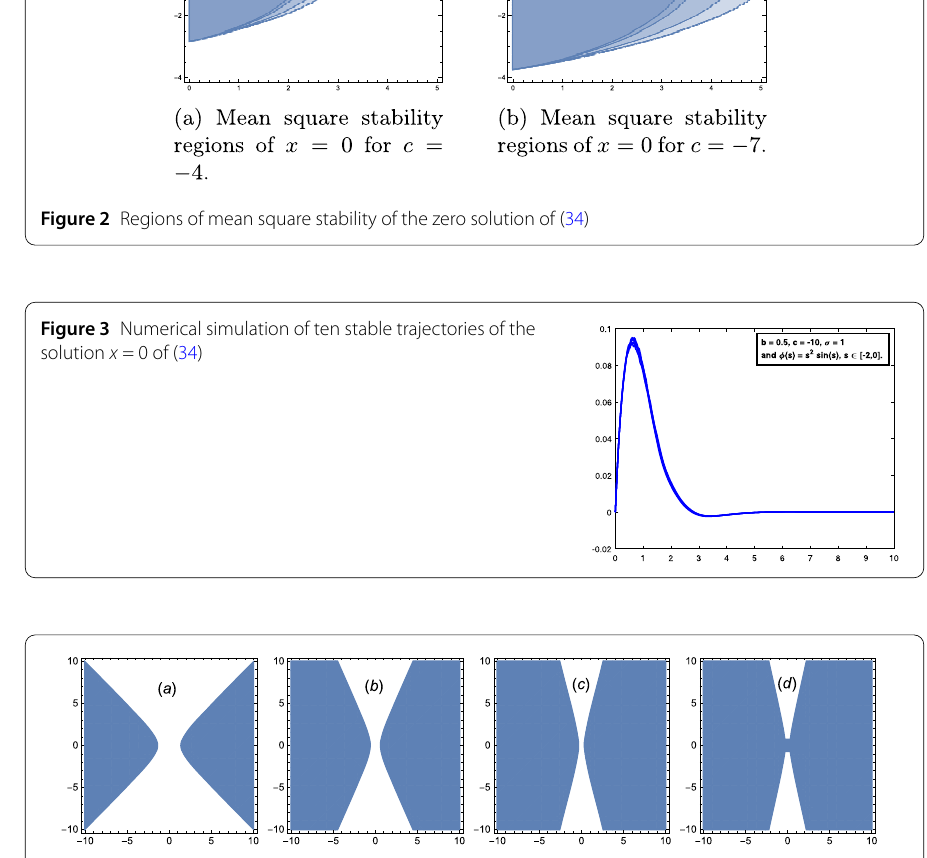
Figure 4 Regions of stochastic stability of (34) for c = 1 in a ( σ , b )-space of